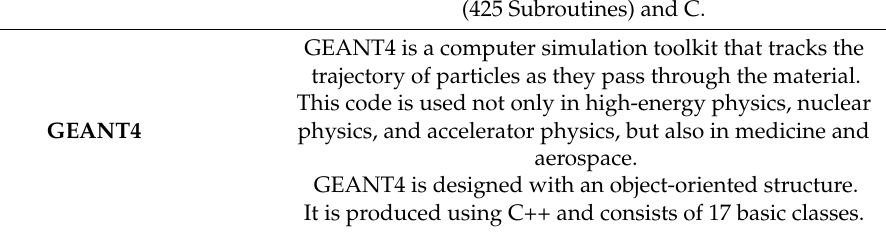
Table 2. Comparison of characteristics of MCNP and GEANT4.